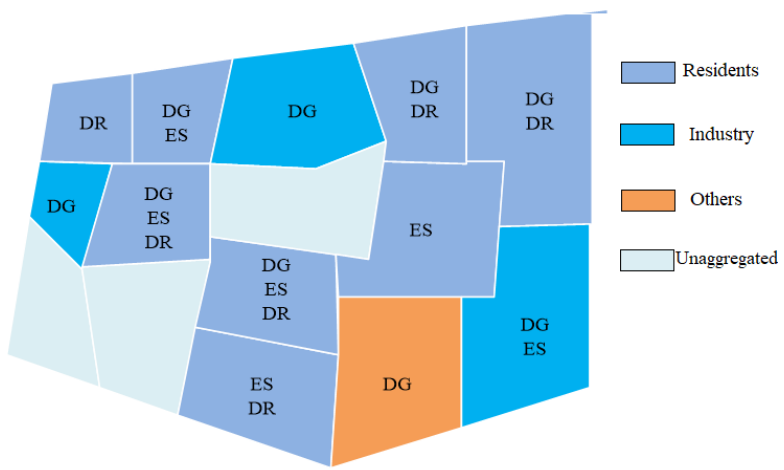
Figure 9. Distribution of distributed energy resources.